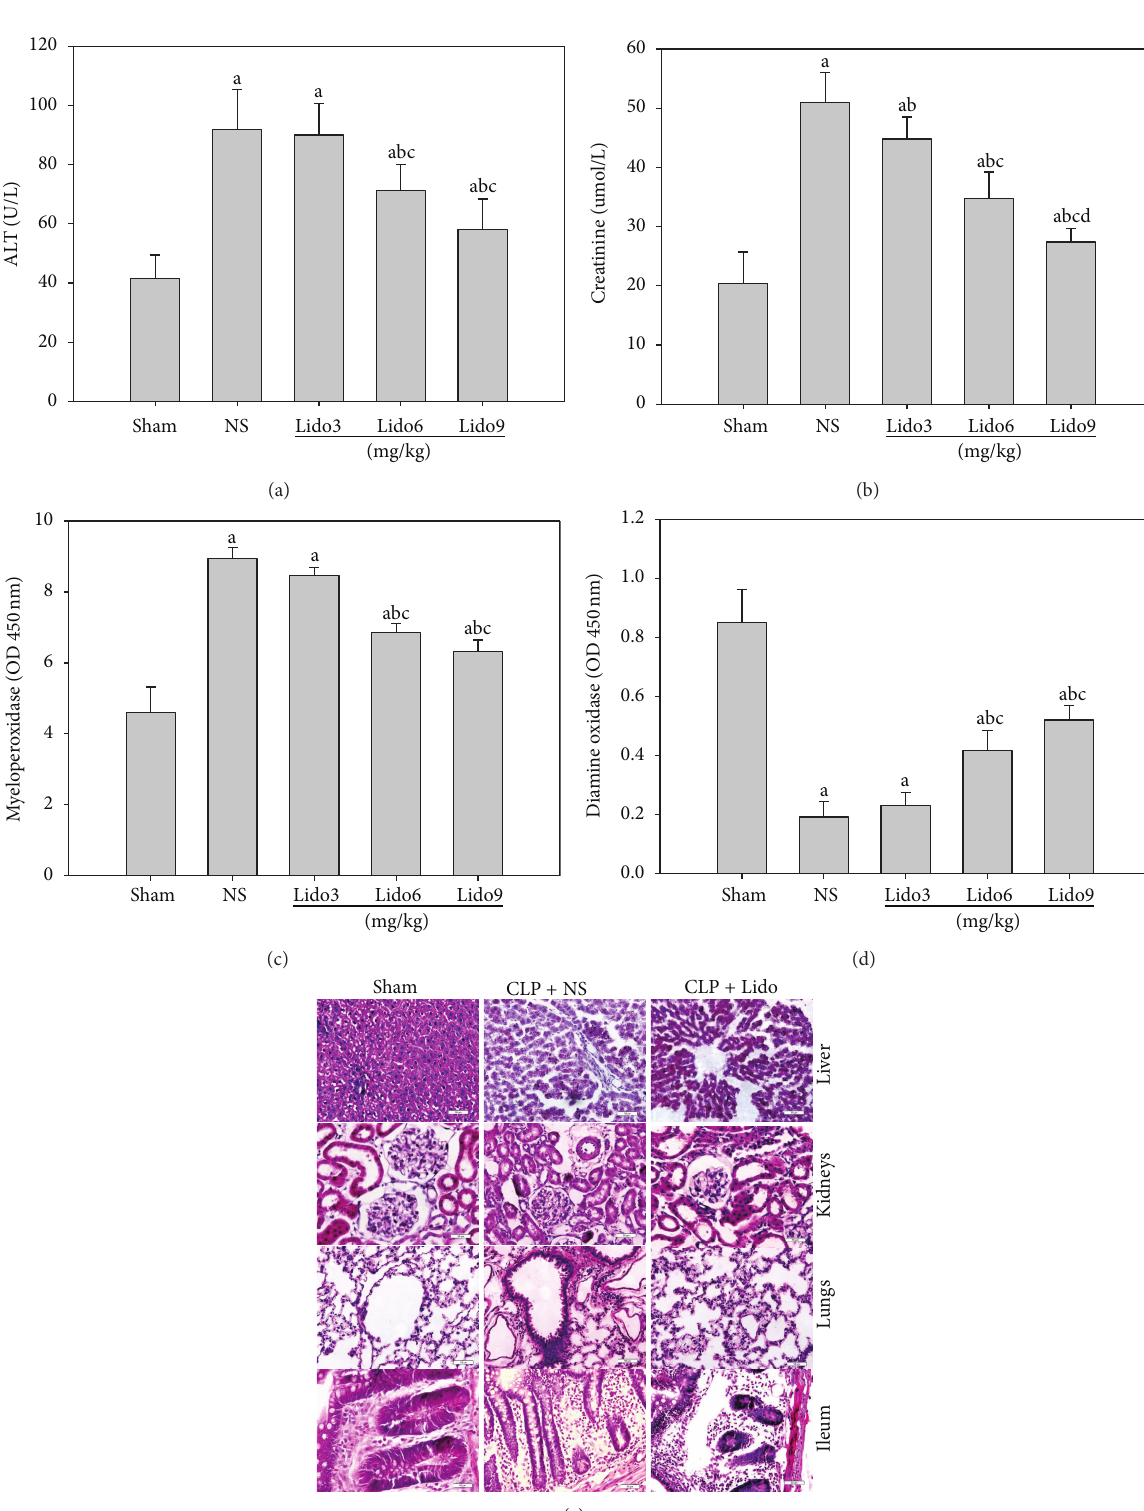
Figure 1: Lidocaine treatment protects acute organ injury induced by CLP. Rats were treated with NS or lidocaine 10h after CLP. Serum, liver, kidneys, lungs, and ileum were collected 24 h after CLP. Plasma contents of ALT (a) and creatinine (b), activity of MPO in lungs (c), and DAO in ileum (d) were measured. Data were presented as mean ± SD ( 𝑛 = 5 ). a 𝑃 < 0.05 versus Sham; b 𝑃 < 0.05 versus NS; c 𝑃 < 0.05 versus Lido3 mg/kg; d 𝑃 < 0.05 versusLido6mg/kg.(e)Hematoxylinandeosinstainedsectionsofliver,kidneys,lungs,andileumfromratssubjected to Sham and to CLP treated with NS and rats subjected to CLP treated with lidocaine 9 mg/kg at 24 h after CLP. Original magnification: × 400. NS: normal saline; Lido: